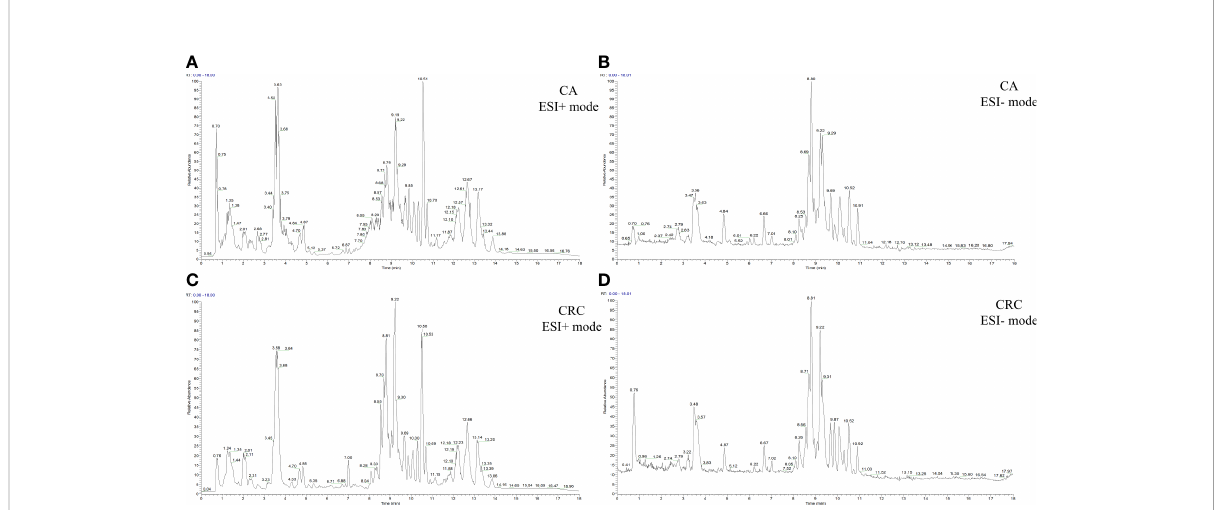
FIGURE 1 The TIC chromatography of CA and CRC groups in both ESI modes. TIC chromatography for serum lipidomics of CA in ESI+ and ESI − modes, respectively (A, B) ; TIC chromatography for serum lipidomics of CRC in ESI+ and ESI − modes, respectively (C, D)